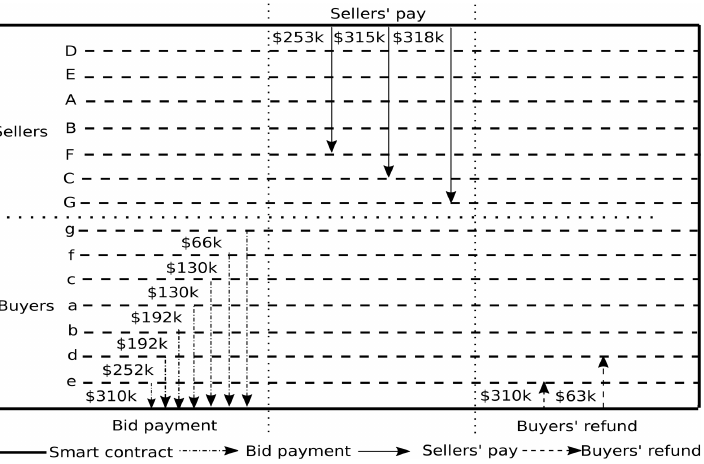
Figure 7. Smart contract execution of energy double auction payments. Energy buyers make payment along with their bids, to the smart contract. The contract pays successful sellers and refunds unsuccessful bidders.